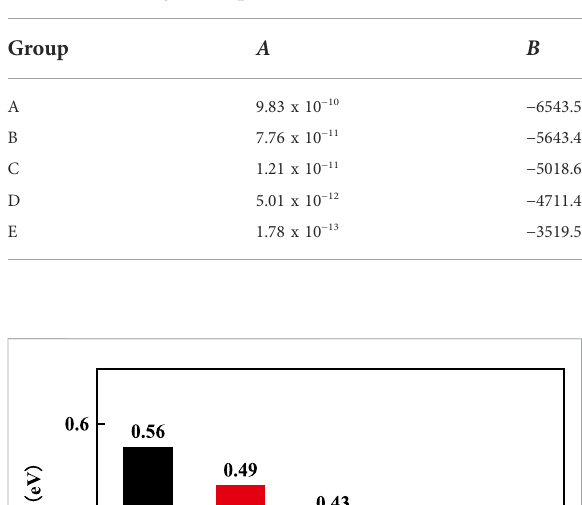
TABLE 1 Parameter of the fi tted curve of electrical conductivity- temperature characteristic. Fitted function: γ = A exp (B/ T )